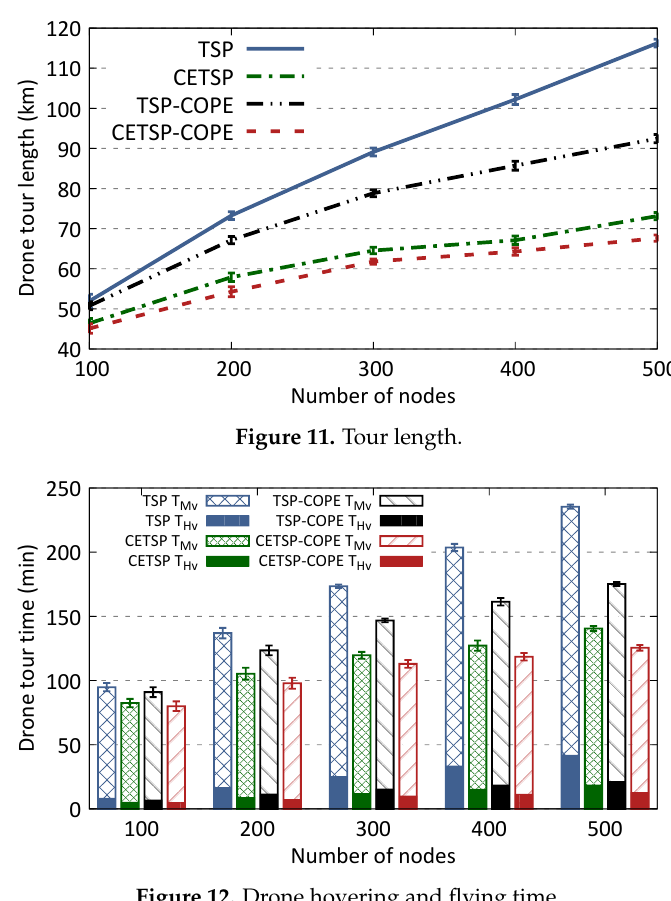
Figure 12. Drone hovering and flying